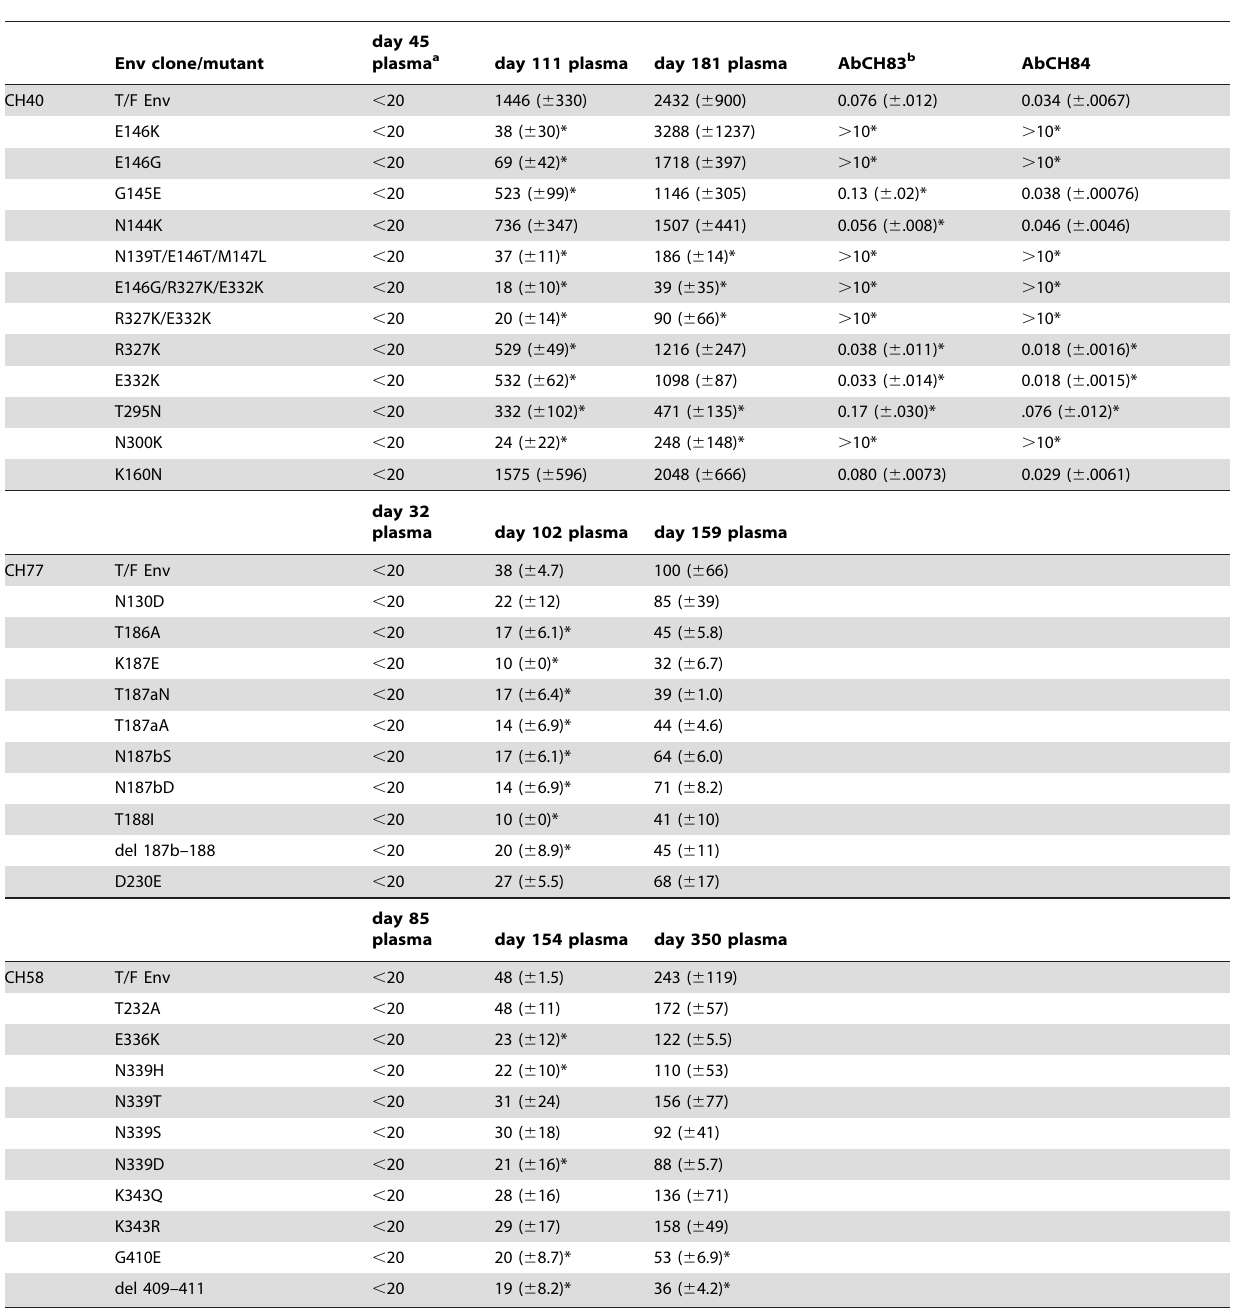
Table 1. Neutralization sensitivities of Env clones and site-directed mutants to autologous plasma and monoclonal antibodies.